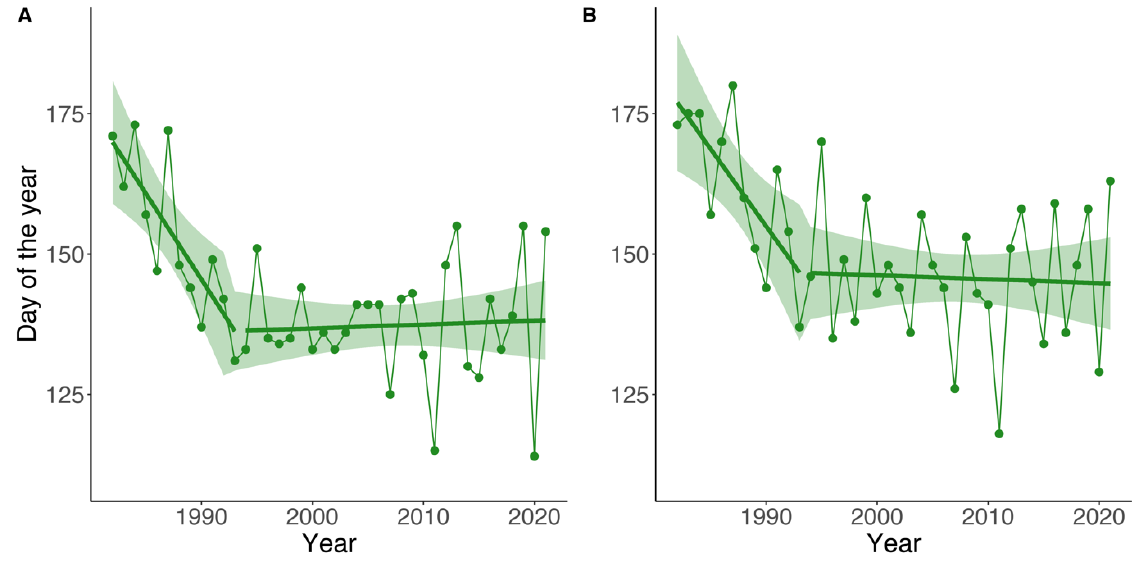
Figure 1 . Trends of breeding phenology over the study period (1982–2021). (A) First day of the breeding season (day of the year, where January 1st = 1). The segmented green line is the result of a piecewise regression, where the year 1993 (± 5; 95% CI) was identified as a breakpoint, thus creating two distinct trends. (B) Date of peak breeding (i.e., date where most toads were captured in a given breeding season. The segmented green line is the result of a piecewise regression, where the year 1993 (± 6, 95% CI) was identified as a breakpoint. The green band in both plots represents the 95% CI for the piecewise regression. Table 1. Summary of the piecewise regressions on the start and peak of the breeding season. For both intercept and slopes we show the estimate, its standard error, and the t-value and p-value associated with it. Slope1 refers to the segment before the breakpoint and Slope2 refers to the segment after the breakpoint. Asterisks next to the p-values show significance at the 0.05 level. The p-value for Slope2 is NA since standard asymptotics do not apply (Muggeo, 2008). No p- values are provided for the intercept because this test is not of biological interest. Std. Error t-value